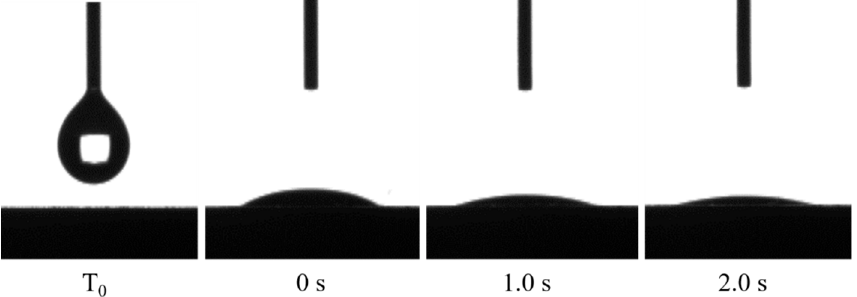
Figure 9. Contact angle of fly ash samples.